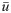
As period driving amplitude increases, global oscillations accelerate and become gradually more linear.The network mean activity u¯ is shown (top panels) with a close up view of a few cycles (center panels) with the associated response function (bottom panels), for various input amplitudes. A. Io = 0.01. B. Io = 0.1. C. Io = 1.0. Other parameters are α = 100Hz, β = 2500/mV, g = −2mV/Hz, s = 4mV/Hz, τ = 25ms.